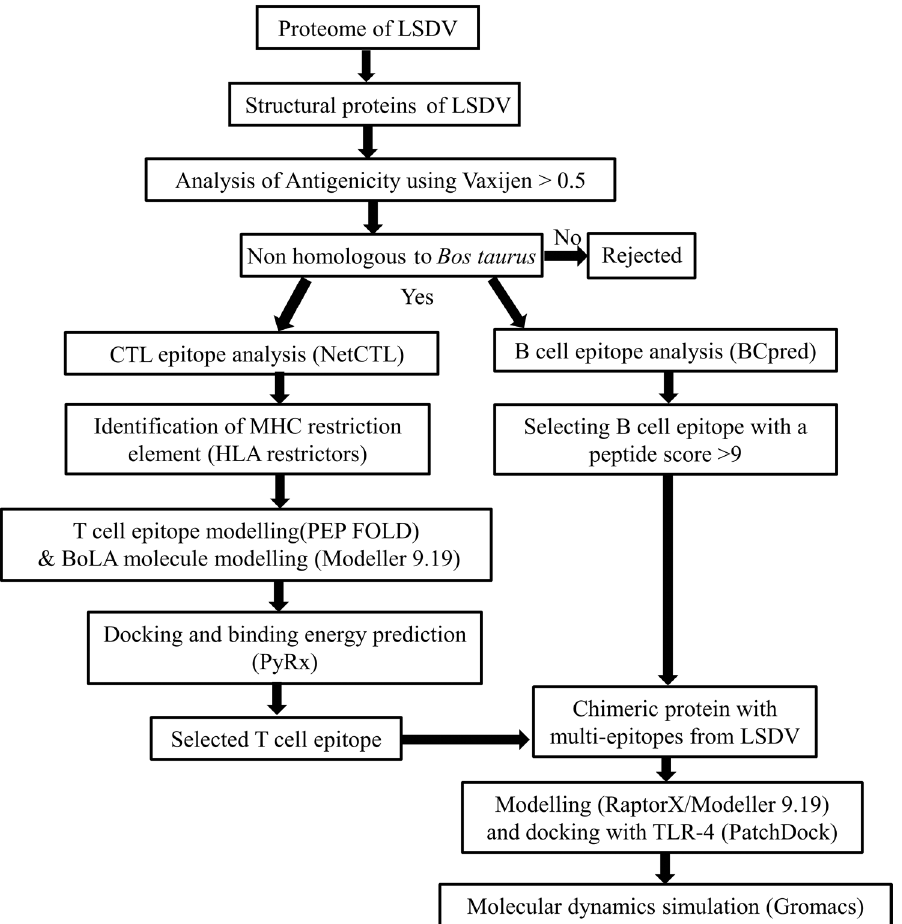
Figure 1. Systemic representation of designing a multi-epitope